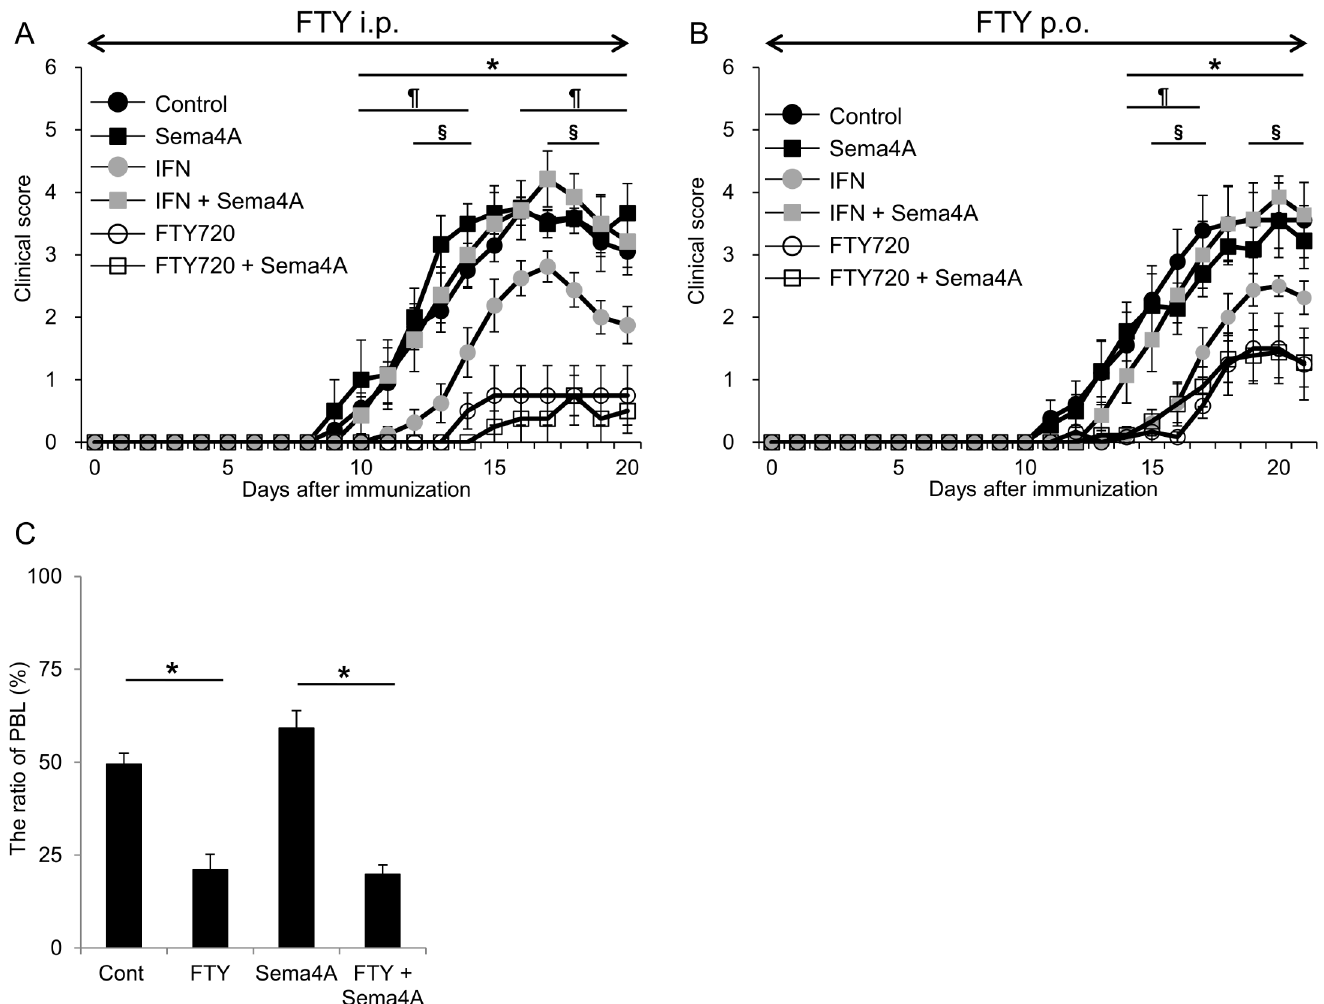
Fig 4. Fingolimod is effective for mice with EAE given Sema4A-Fc. (A), (B) The mean clinical scores of mice with EAE are shown. Immunized mice were treated with PBS + human IgG (Control; filled squares, n = 10), PBS + Sema4A-Fc (Sema4A; filled triangles, n = 8), IFN- β + human IgG (IFN; filled diamonds, n = 7 in (A), 8 in (B)), IFN- β + Sema4A-Fc (IFN + Sema4A; open circles, n = 7), Fingolimod + human IgG (FTY720; open squares, n = 8) or Fingolimod + Sema4A-Fc (FTY720 + Sema4A; open triangles, n = 8). Fingolimod is effective in mice with EAE given Sema4A-Fc. Administration method of fingolimod was intraperitoneal (i.p.) in (A) and oral (p.o.) in (B, C). Data represent the mean score ± SEM of two independent experiments. (cid:3) p (cid:20) 0.05 for Fingolimod versus Control; ¶p (cid:20) 0.05 for IFN versus Control.; §p (cid:20) 0.05 for IFN+ Sema4A versus IFN. (C) The ratio of peripheral blood lymphocytes of mice with EAE at day 22 after immunization. (cid:3) p (cid:20)